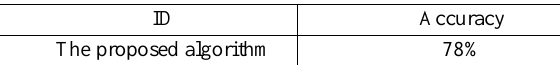
Table 1. The result of